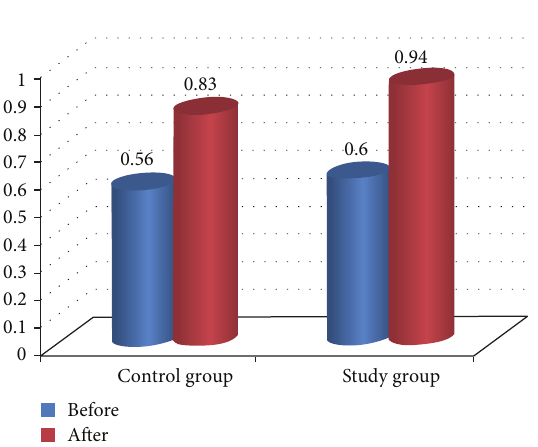
Figure 3: Comparison between pre- and posttreatment in popliteal angle for both groups.